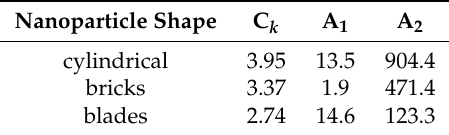
Table 2. Constant coefficients defined in Equation (20) and Equation (21) for the effective viscosity and thermal conductivity of the nanofluid for various nanoparticle shapes